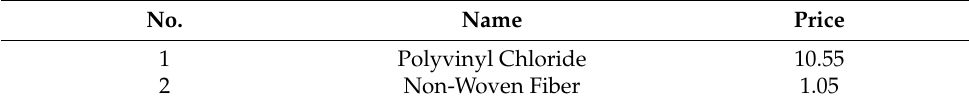
Table 3. Cost per unit area of polyvinyl chloride and non-woven fiber.